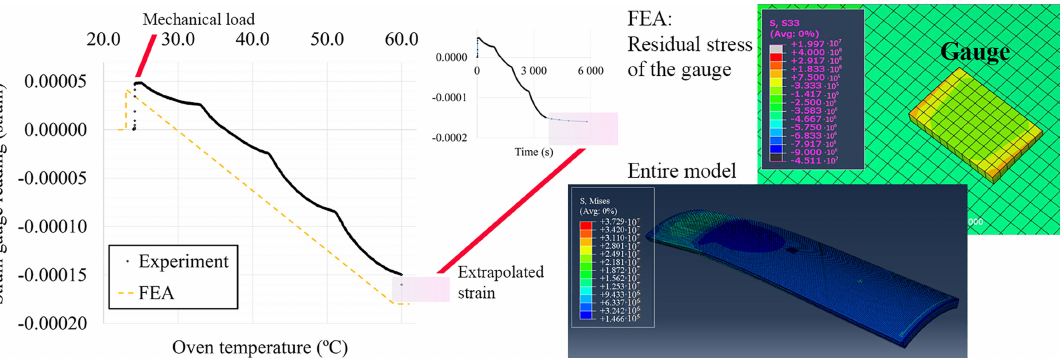
Figure A1. The experimental and the finite element analysis results used for the determining of GFRP’s thermal expansion